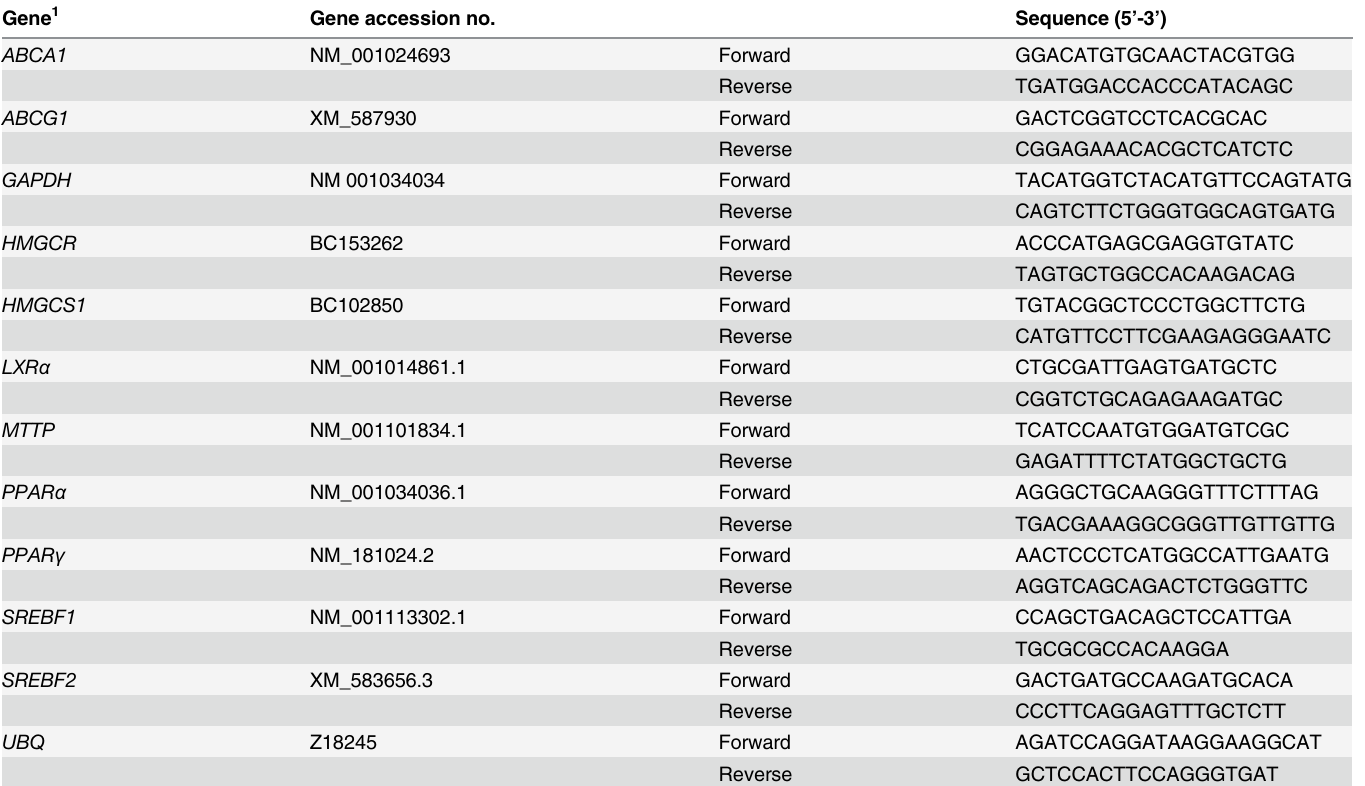
Table 1. Sequence of forward and reverse primers for real-time PCR. Gene